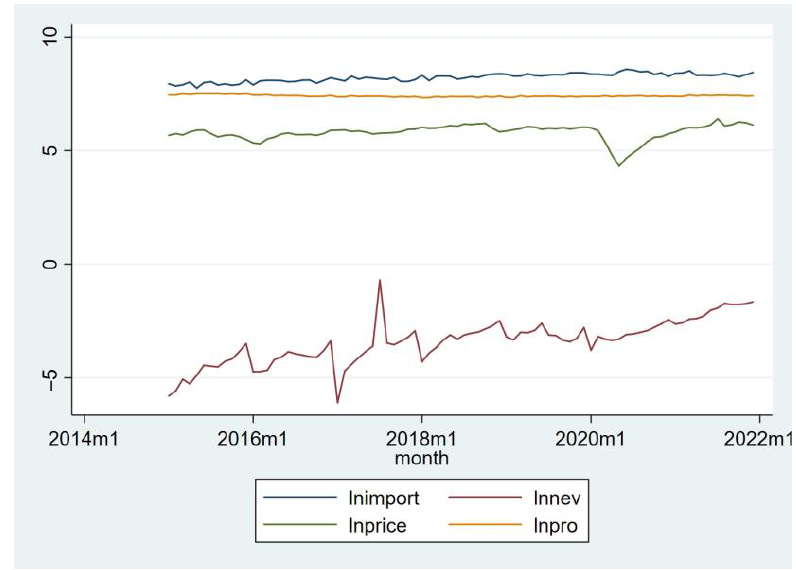
Figure 2. Time trends of the logarithmic values of the variables. the logarithmic values of each variable with lag order Pmax = [12 − (T/100)1/4] = 11.49, taking Pmax = 11 and sequentially making p = 10, 9, . . . until the lag order is 5, the